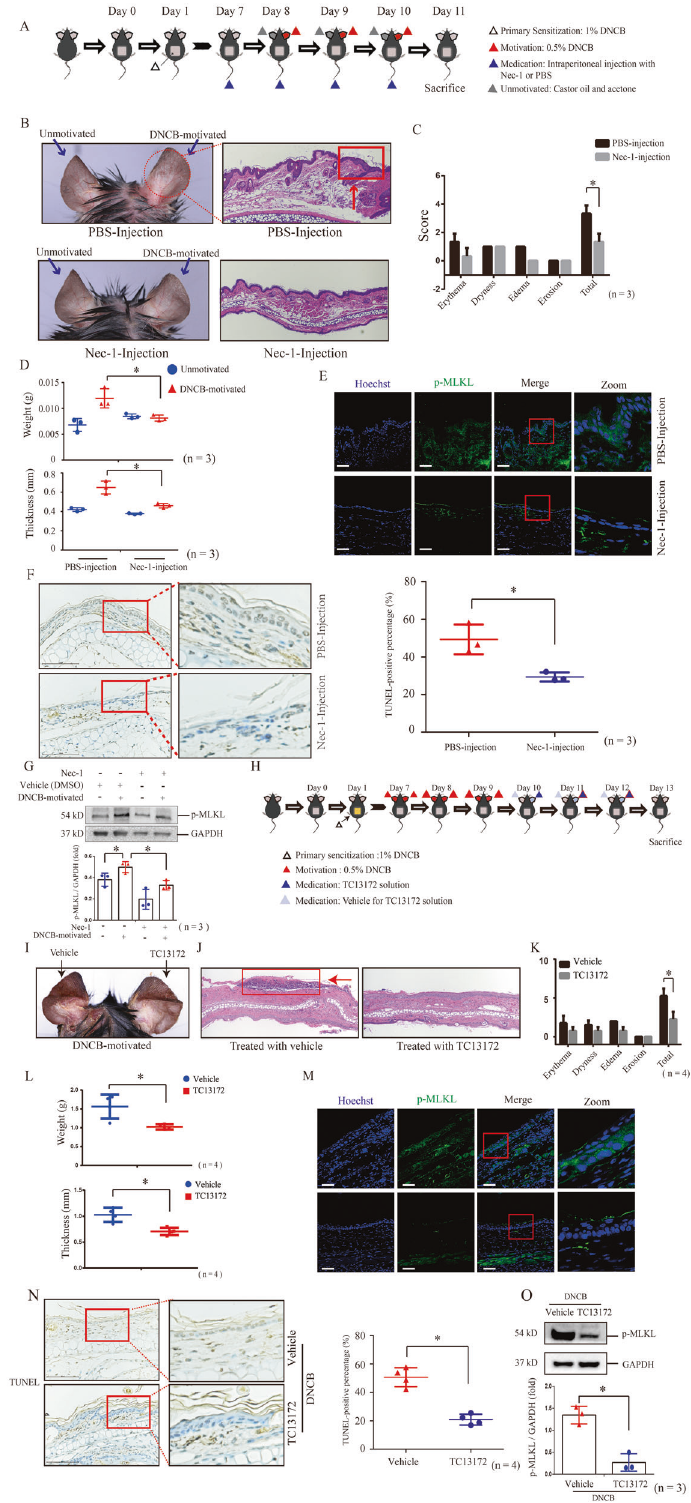
(Fig. 1E). Weight and thickness of DNCB-motivated ears were increased due to skin in fl ammation, compared with unmotivated ears (Fig. 1E). Histologically, DNCB-motivated ears showed that hypertrophy, edema and local epidermal necrosis and in fi ltration of in fl ammatory cells (Fig. 1F). Next, we determined the total